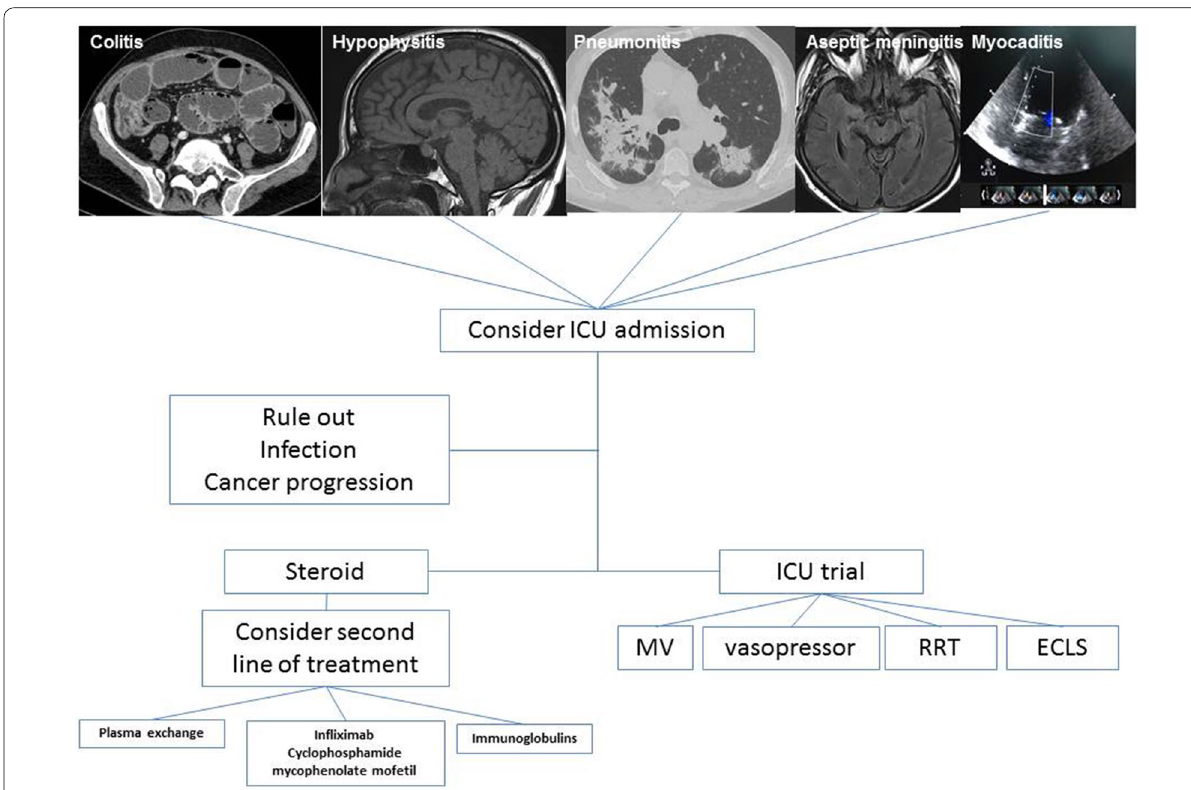
Fig. 6 Management of the most frequent IrAEs in the ICU. ICU intensive care unit, MV mechanical ventilation, RRT renal replacement therapy, ECLS extracorporeal life